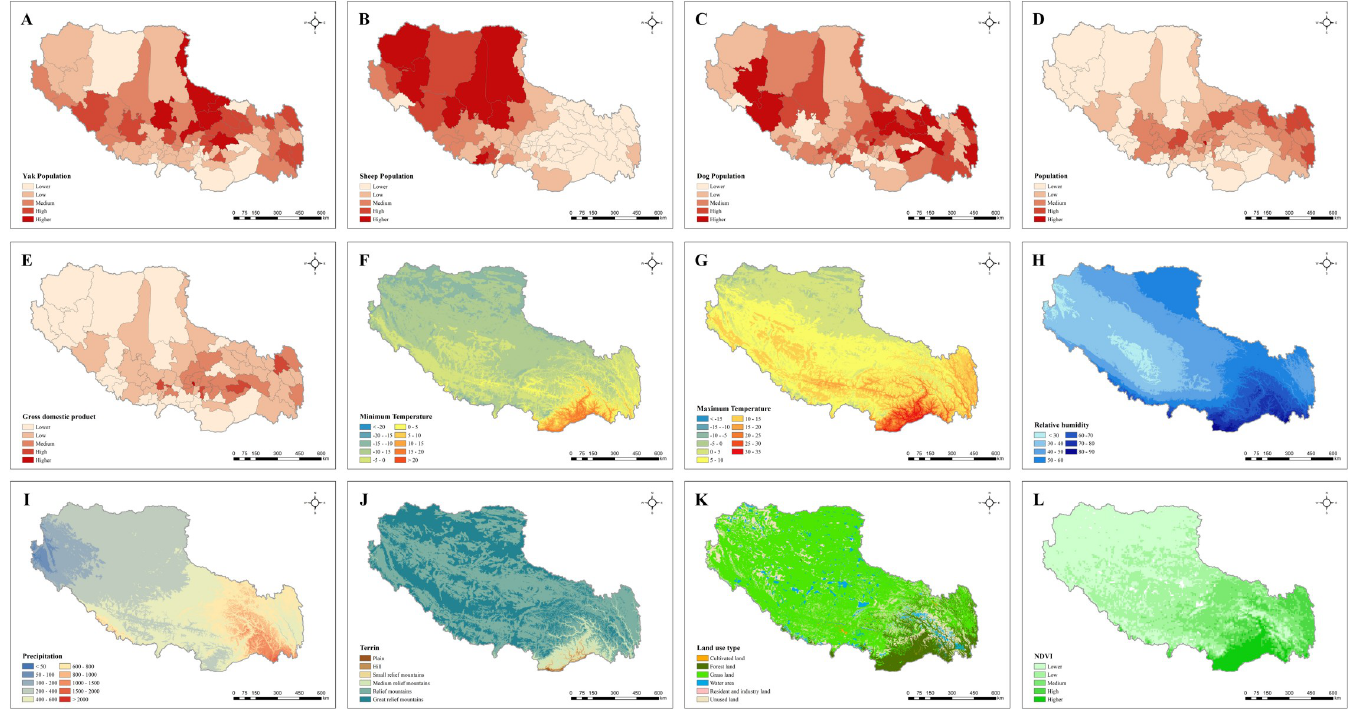
Fig 3. Spatial distribution of environmental proxies. Note: A = Yak population, B = Sheep population, C = Dog population, D = Population, E = GDP, F = Minimum temperature, G = Maximum temperature, H = Relative humidity, I = Precipitation, J = Terrain, K = Land use type, L = NDVI. Abbreviations: GDP, gross domestic product; NDVI, normalized difference vegetation index. Source of map: https://www.worldofmaps.net/typo3temp/images/chinakarte.jpg.